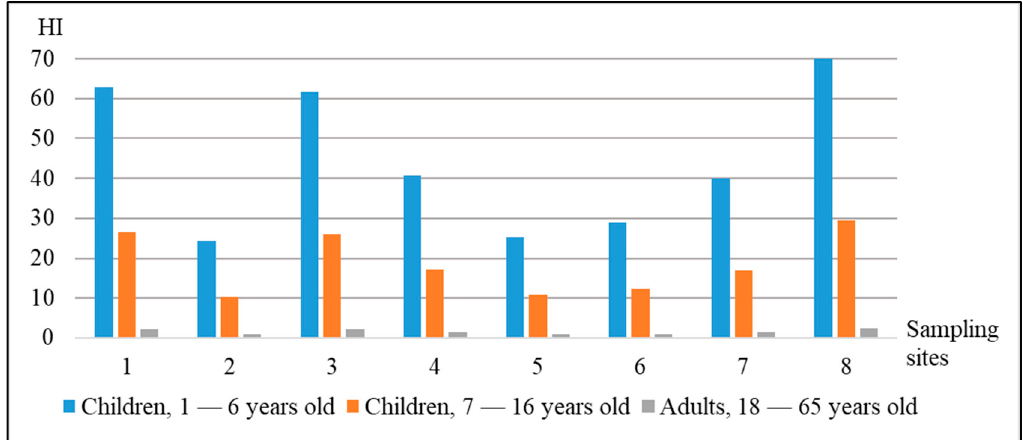
Figure 5. Estimation of the total non-carcinogenic risk for the groups of adult and children population.